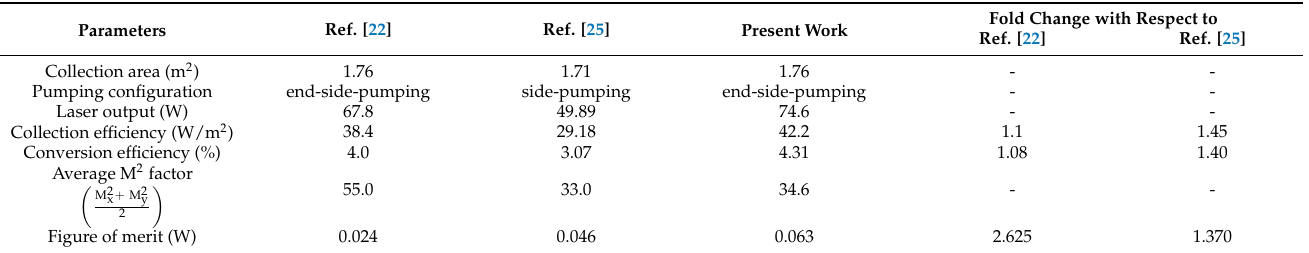
Table 6. Comparisons between results obtained in this work and previous record results for end-side pumping [22] and side pumping